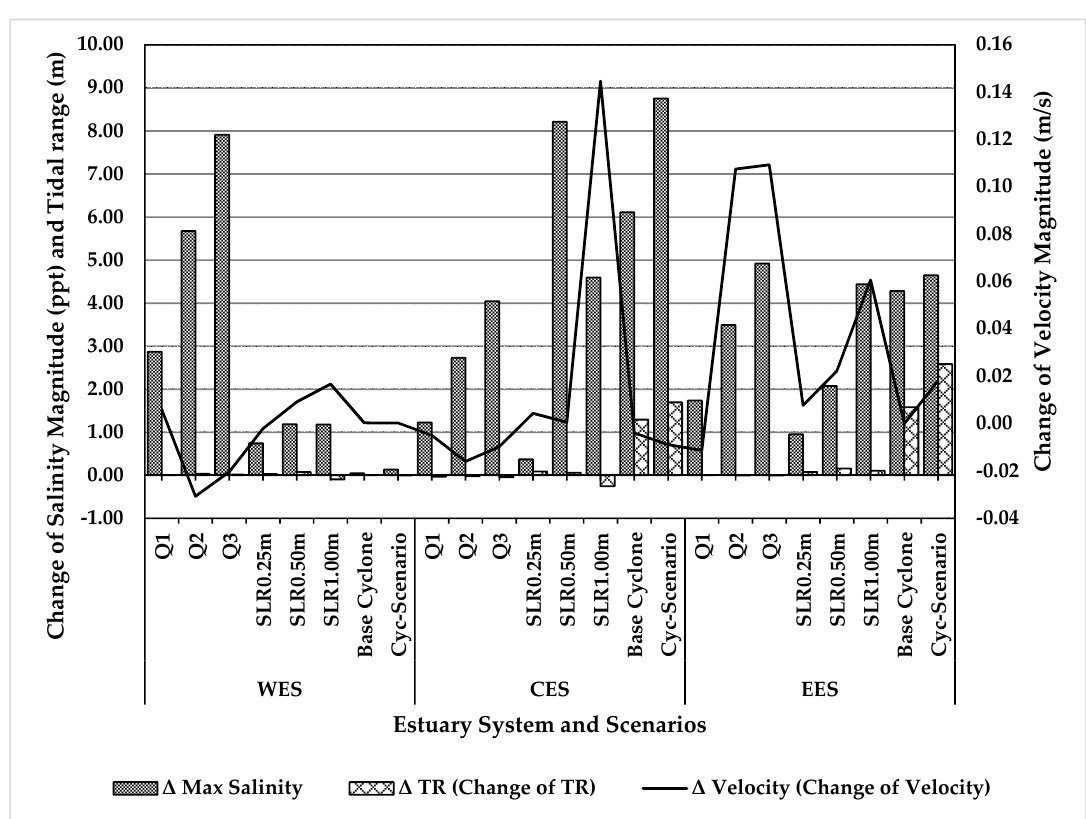
Figure 12. Change of maximum salinity ( ∆ Max Salinity), tidal range ( ∆ TR), and flood tide velocity ( ∆ Velocity) along three coastlines. The changes denoted by ∆ represents change from the base condition. The -ve values indicates reduction from base values and +ve values indicates increase from base values.